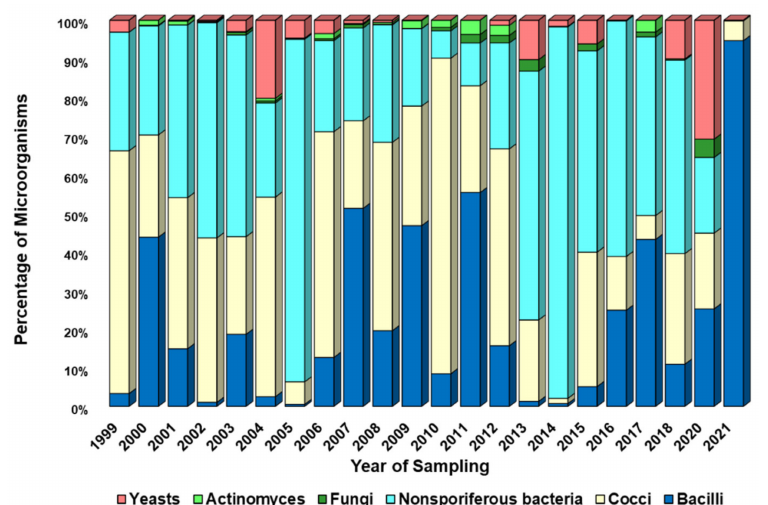
Figure 6. Average annual variability of the ratio of culturable microorganisms in samples obtained during airborne sounding of the atmosphere. Explanations in the text.